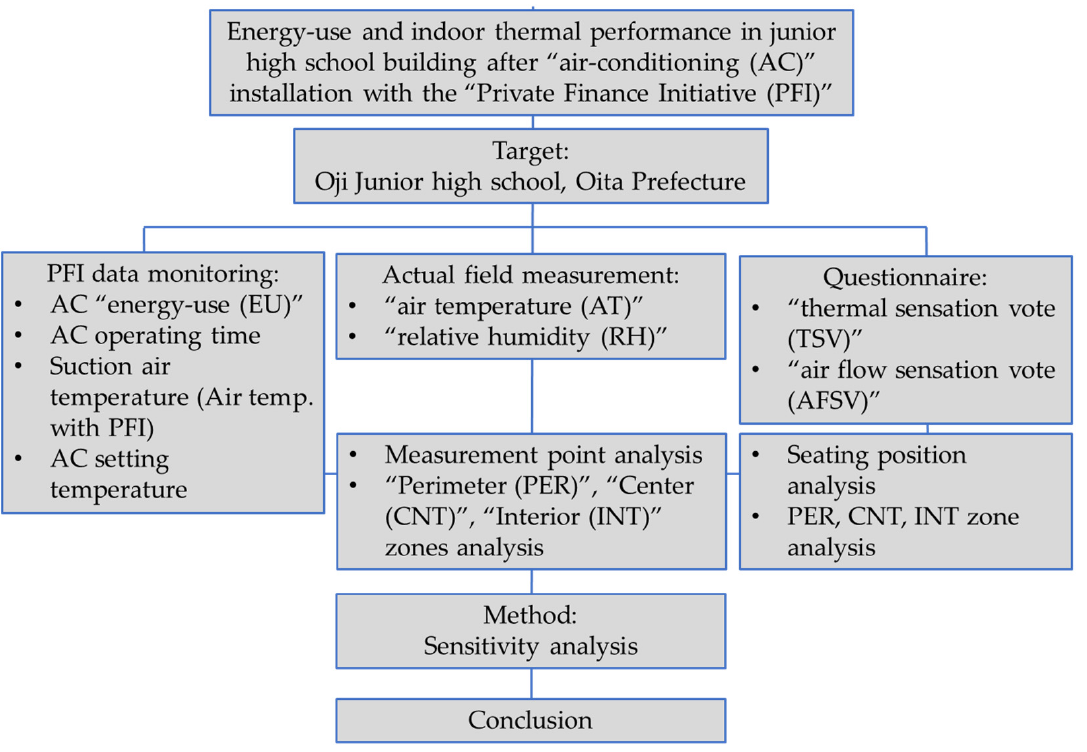
Figure 1. Research framework.